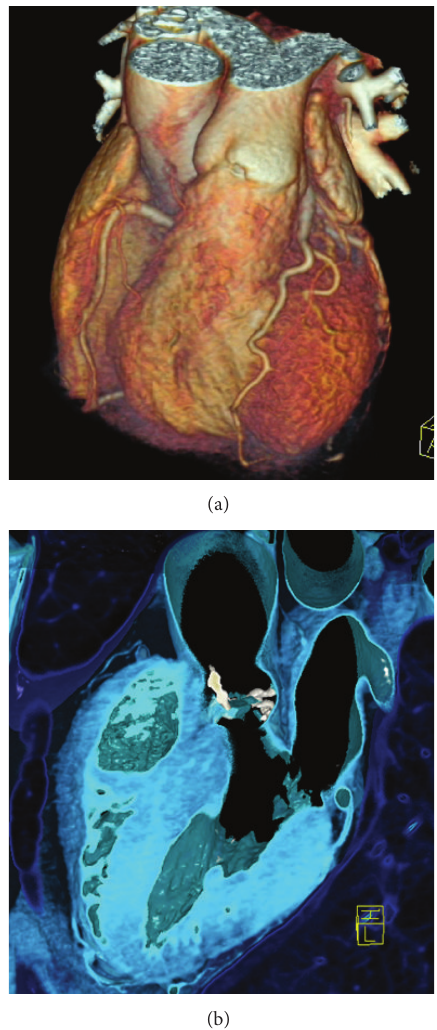
Figure 1: (a) 3-D VRT image of the heart by computed tomography . Thecoronaryarteries(LAD—leftanteriordescending—inthefront) are shown. Cardiac valve evaluation from same CT data set is possible. (see pulmonary valve in the front). (b) 3-D image of the aortic valve. Severe calcification (white color) of the aortic valve are pathognomonic for degenerative aortic stenosis (here shown in 3-chamber view). Further, quantification and characterization of aortic valve and annulus calcium predict complications during transcatheter aortic valve implantation (TAVI) such as postsurgery paravalvular regurgitation or annulus rupture during stent expan- sion.